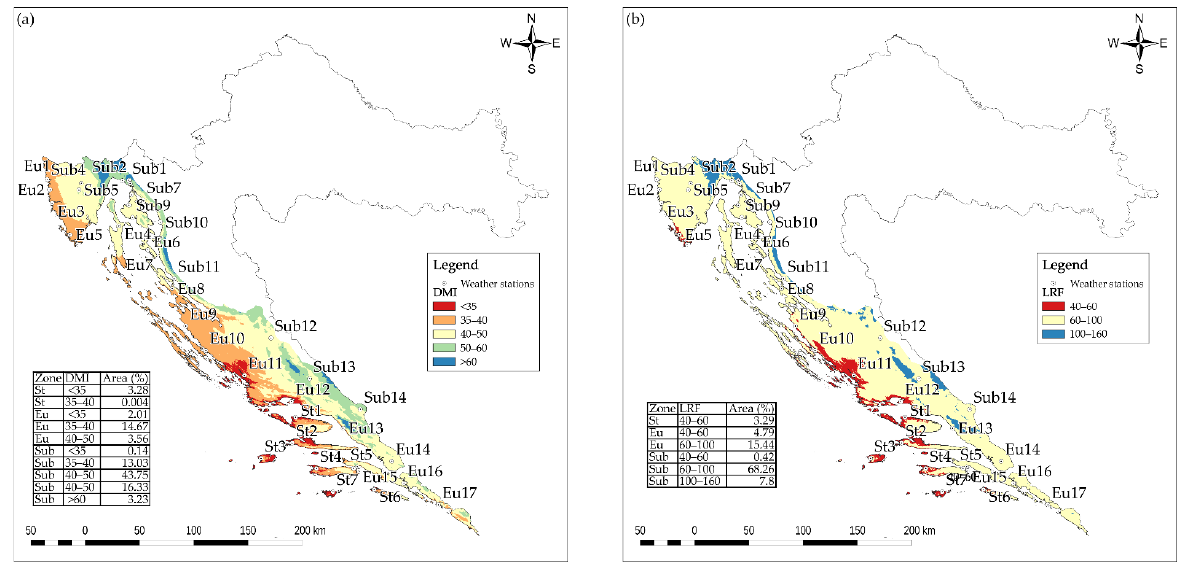
Figure 3. ( a ) de Martonne aridity index (DMI), ( b ) Lang’s rain factor (LRF).